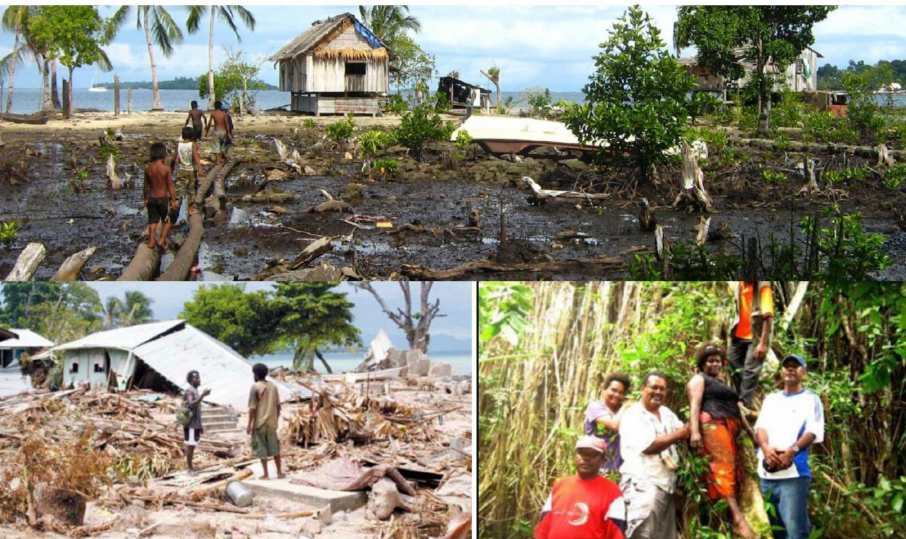
Figure 5. Photographs of villages affected by tsunami. A Gilbertese village showing the close location of the village to the ocean and use of logs for village paths across a mangrove swamp ( top ). Village damage post-tsunami ( bottom left ). Villagers next to a Banyan tree that acted as a vertical escape structure ( bottom right